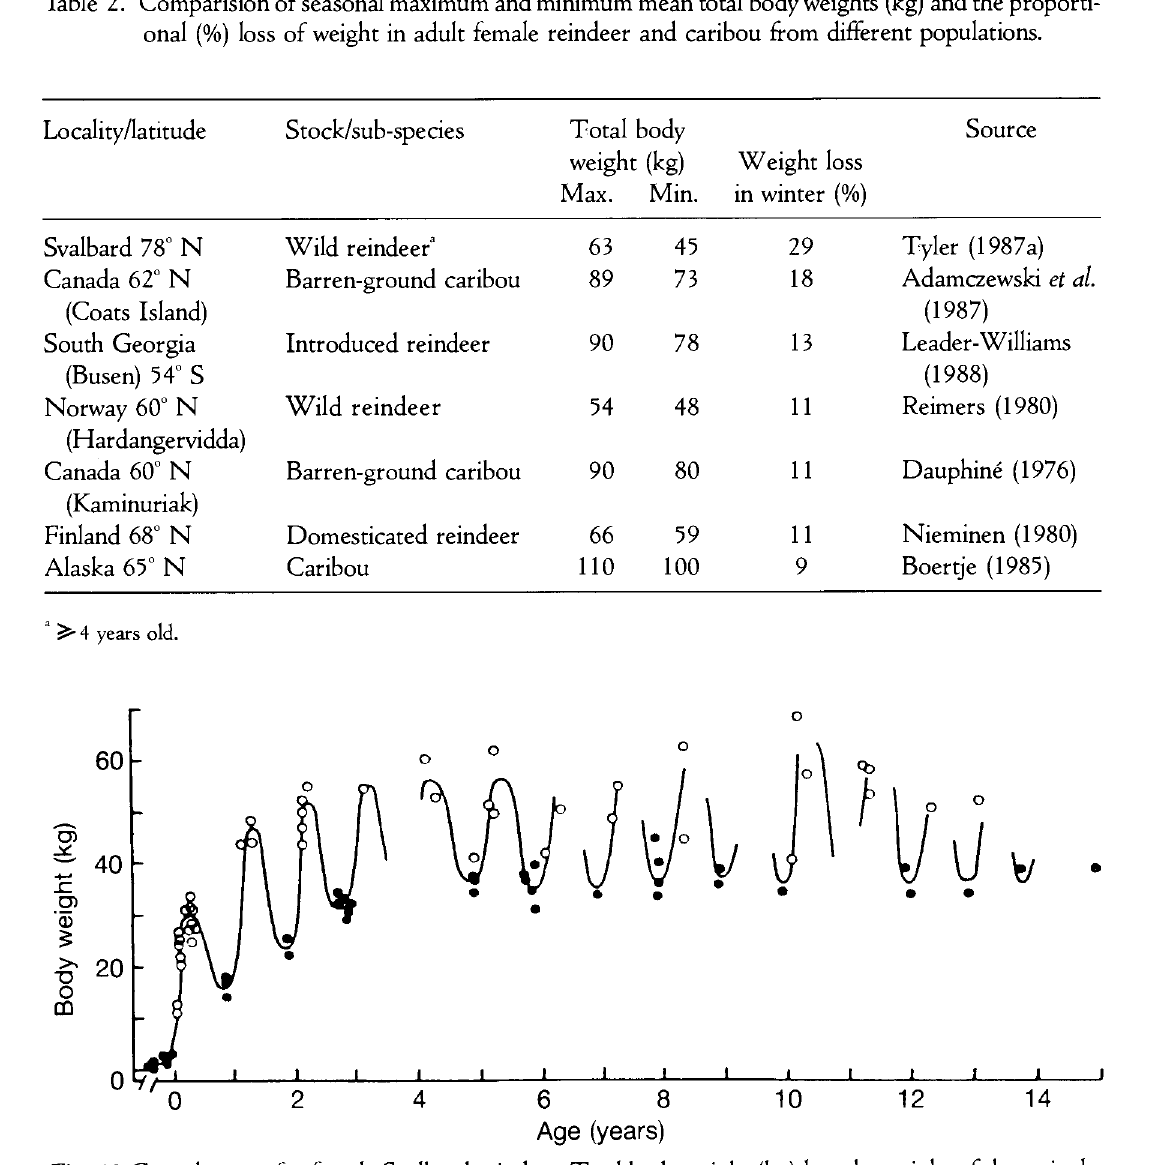
Fig. 10. Growth curve for female Svalbard reindeer. Total body weight (kg) less the weight of the reticulo- rumen (all specimens) and the weight of the uterus and its contents (winter specimens). Each point represents one reindeer. Summer and autumn (July to October) (o); late winter (April to May) (•), from Tyler,